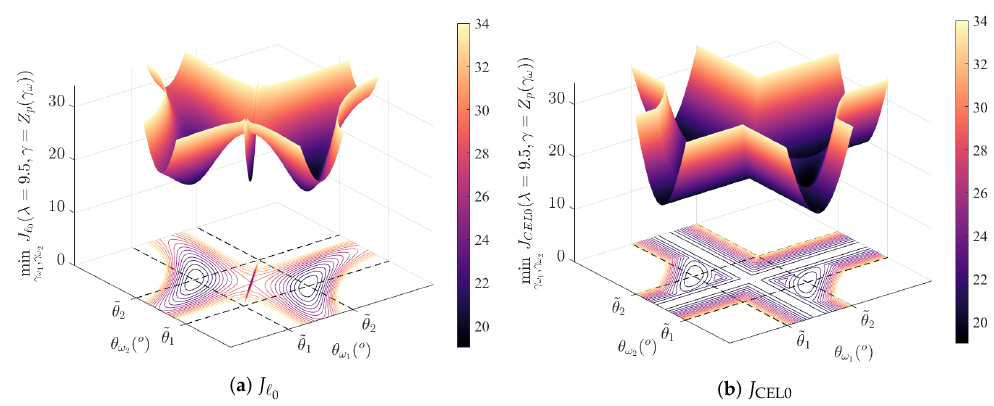
Figure 1. Loss surfaces of J (cid:96) two non-zero components corresponding to directions θ ω true ones ˜ θ 1 = 32° and ˜ θ 2 = 62° ( d and h ) the global minimum indicated by a black filled circle ( γ ω 2 λ = 19. Local minima are indicated by the blue asterisks, while light blue diamonds represent critical points that are not local minima.